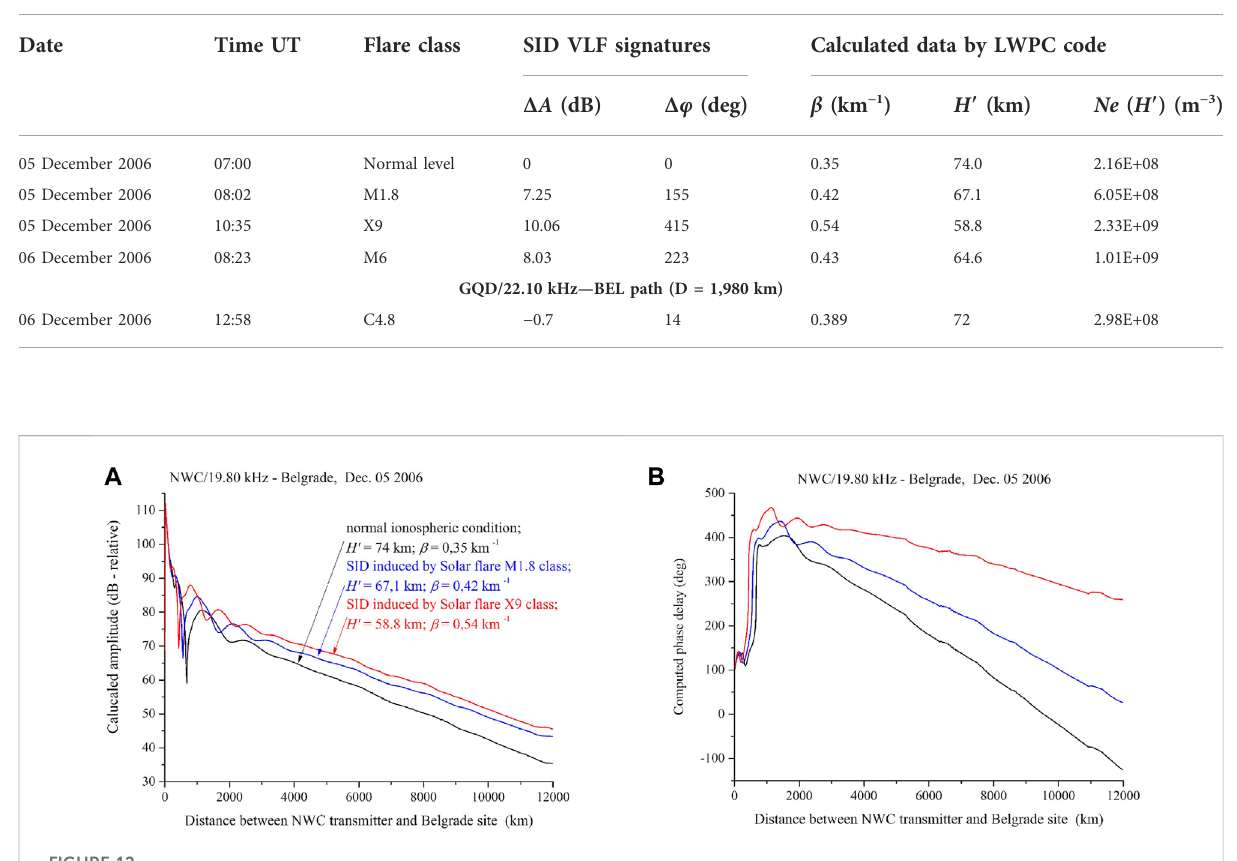
TABLE 3 SID VLF signatures and calculated data by LWPC code as a function of intensity of X-ray fl ux.